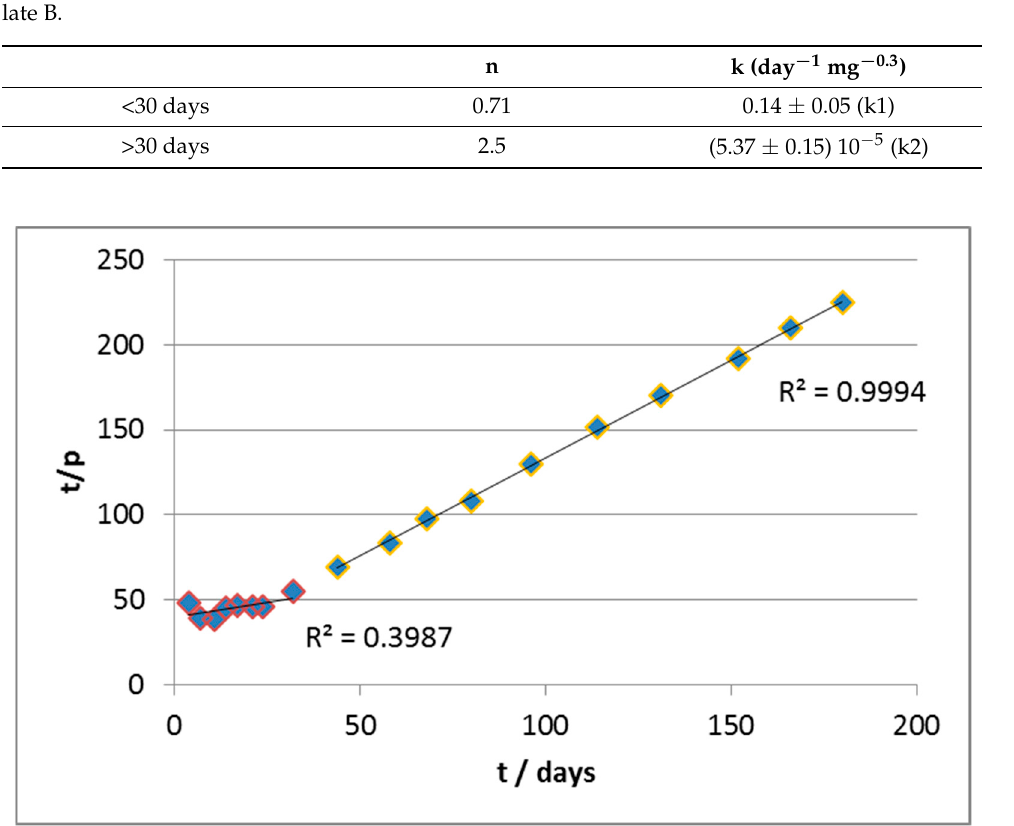
Figure 4. Elaboration of the kinetic data of formulate B according to the Wilkinson model.